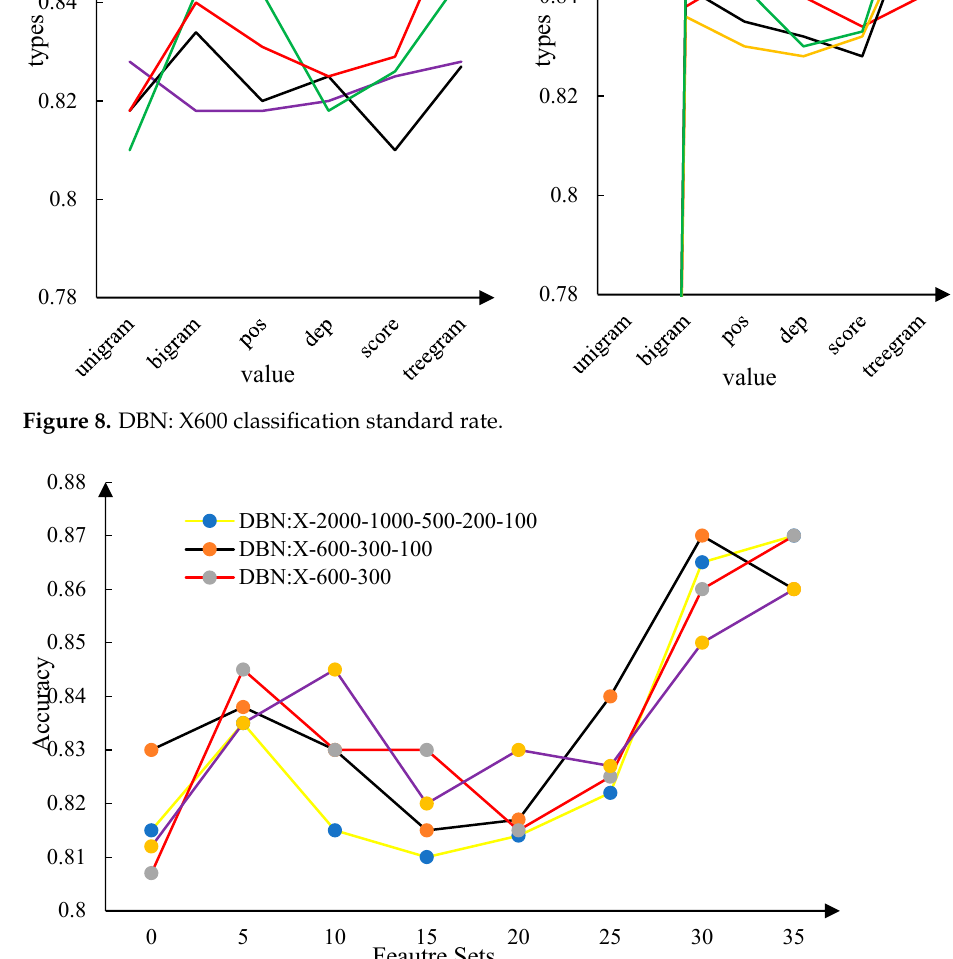
Figure 9. Emotional analysis line chart.